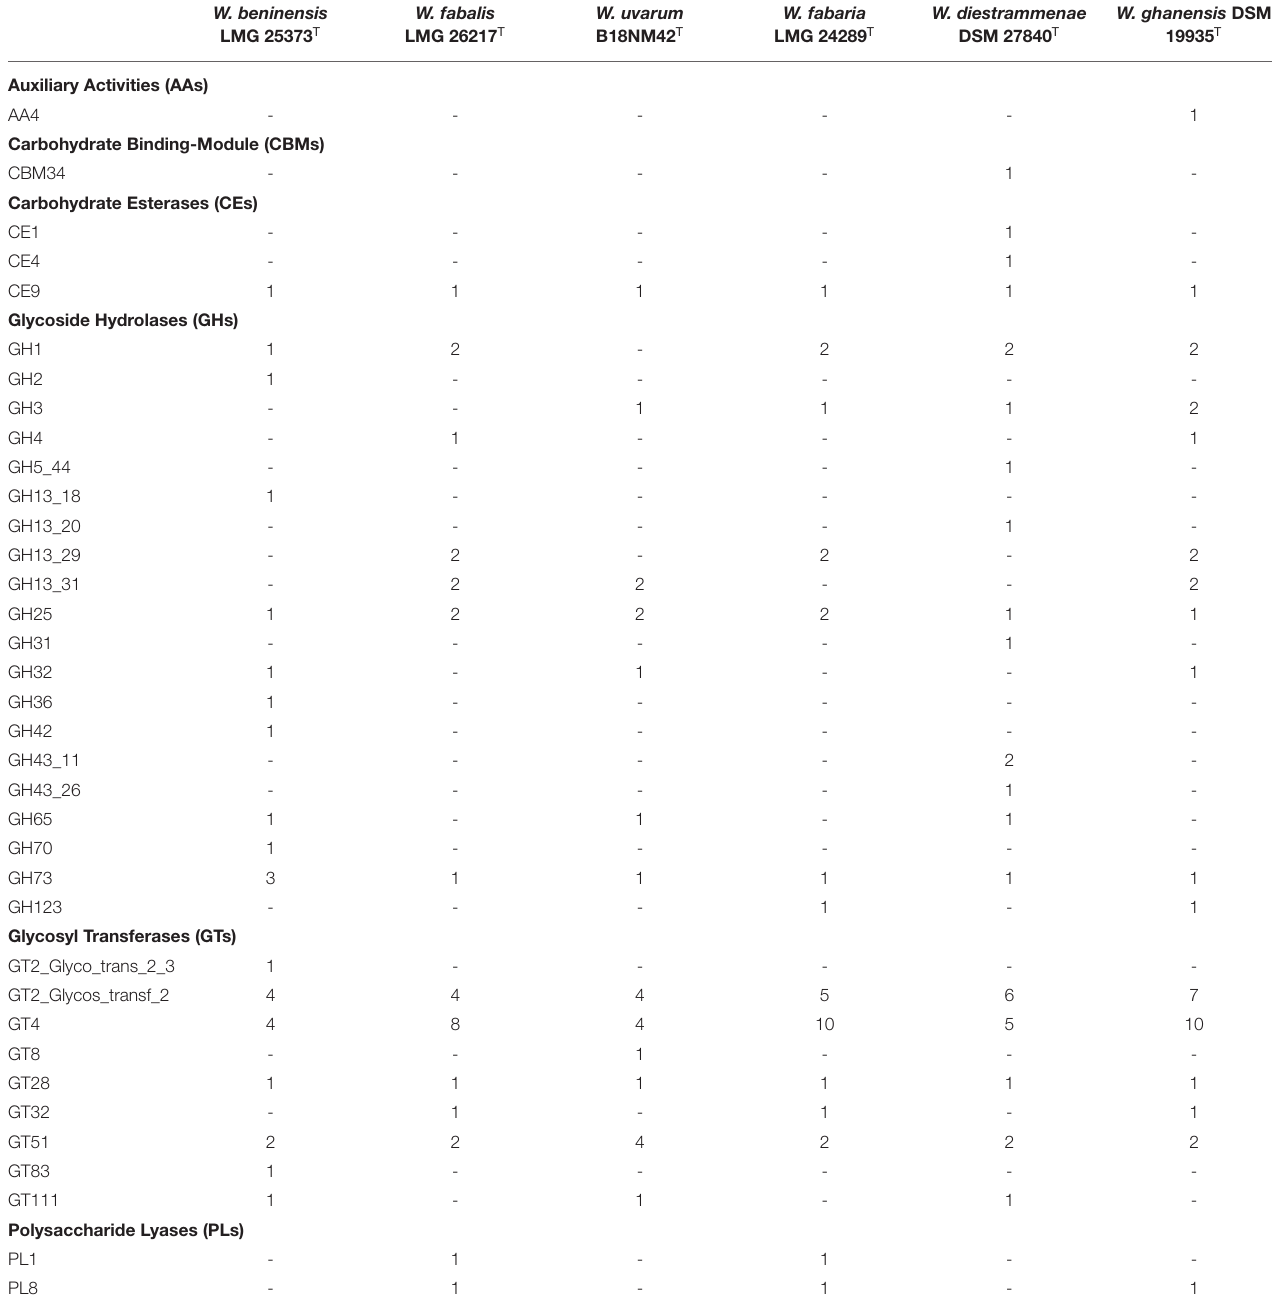
TABLE 2 | Number of CAZymes present in sequenced Weissella